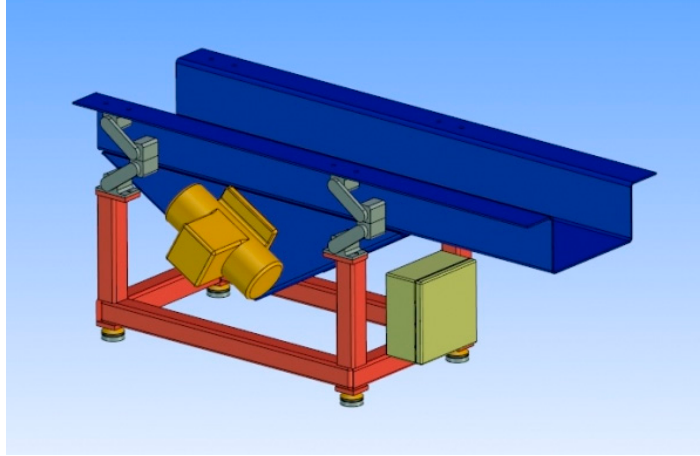
Figure 3. Vibrating conveyor [25] .